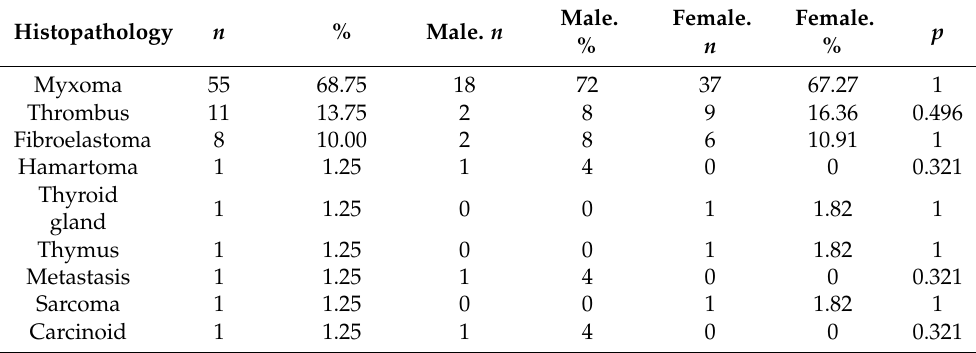
Figure 4. ( a , b ) Exemplary resected left atrial myxoma of approximately 70 mm length and 30 mm diameter. Polypoid tumor with oval shape and smooth, slightly lobulated surface. Note the resected part of the interatrial septum with septal myocardium to which the myxoma is attached (*). Table 4. Histopathology ( n = 80).